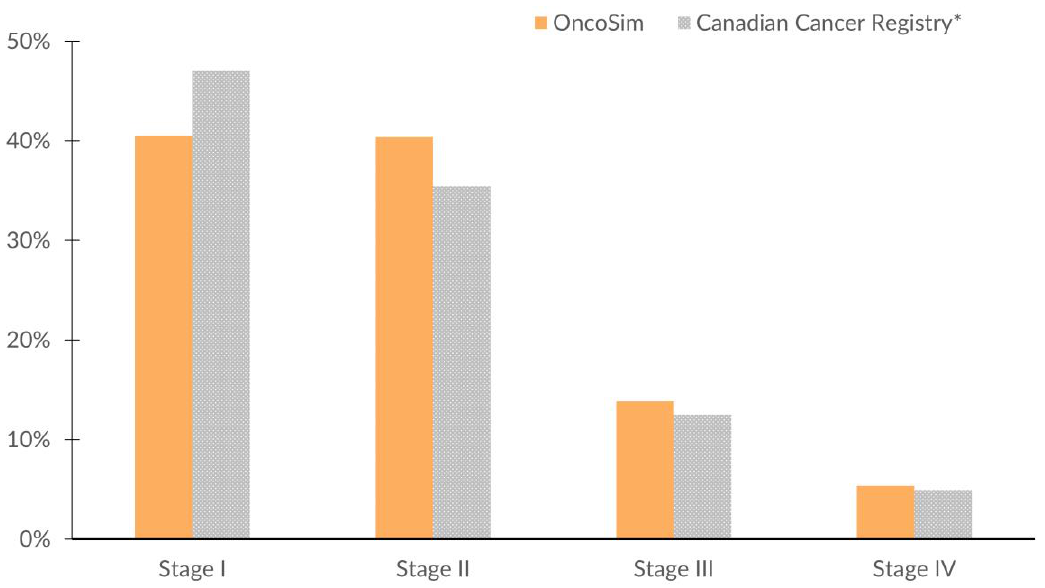
Figure 4. ( A ) Incidence of invasive breast cancer (per 100,000 women) by age group in 1992 – 2013, OncoSim-Breast vs. Canadian Cancer Registry (CCR); ( B ) incidence of ductal carcinoma in situ (per 100,000 women) by age group in 1992 – 2013, OncoSim-Breast vs. Canadian Cancer Registry (CCR). Error bars represent the 95% confidence intervals.